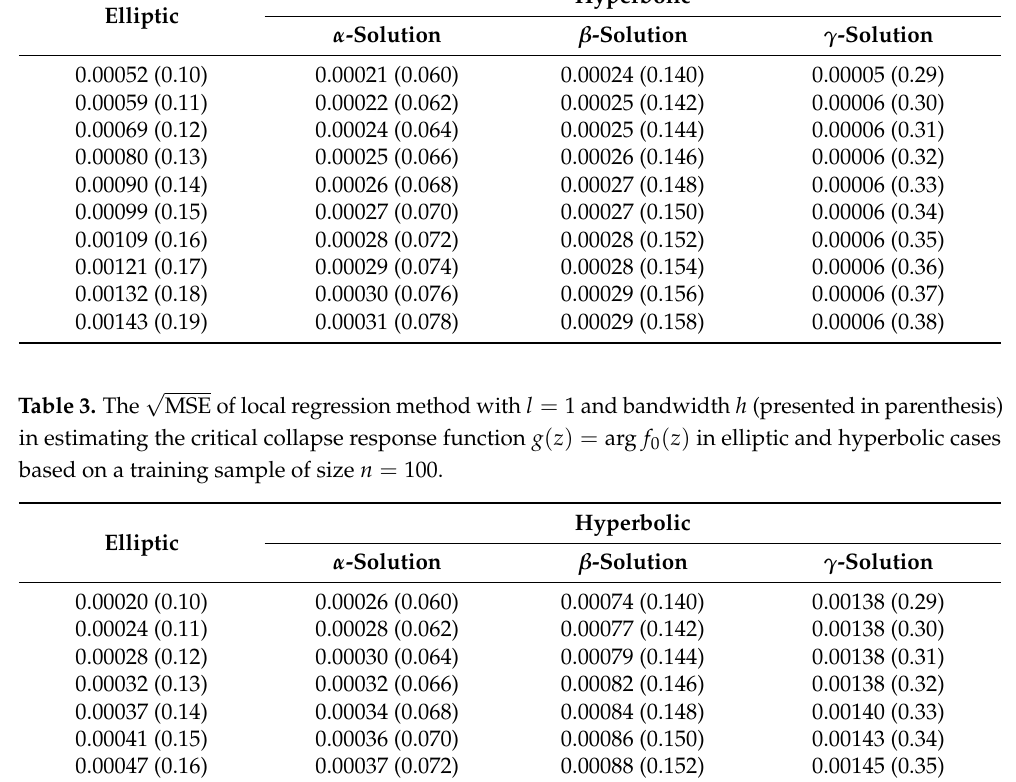
( z ) − z 2 in elliptic and hyperbolic cases 0